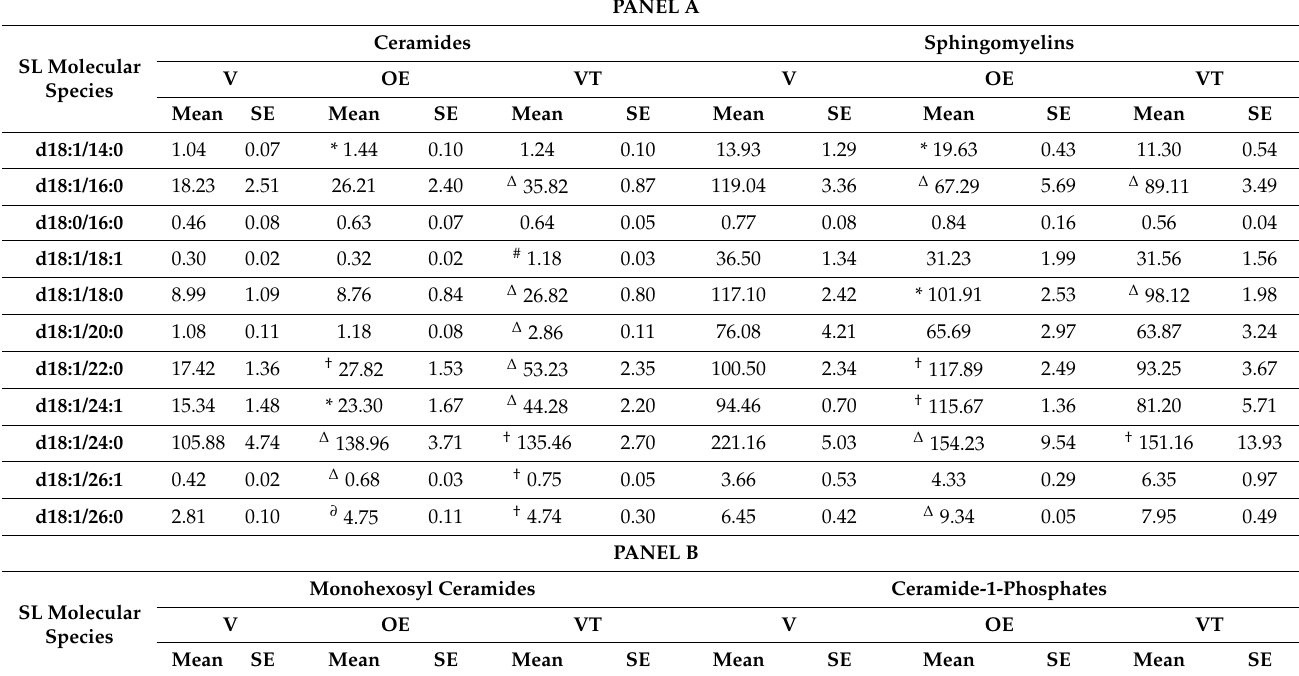
Table A2. INS-1 cell sphingolipid molecular species. PANEL